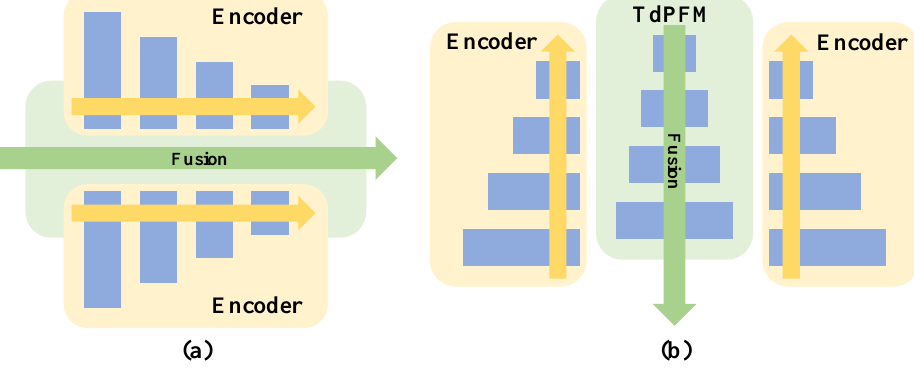
Figure 1. Two kinds of fusion methods, which include ( a ) bottom-up fusion and ( b ) top-down